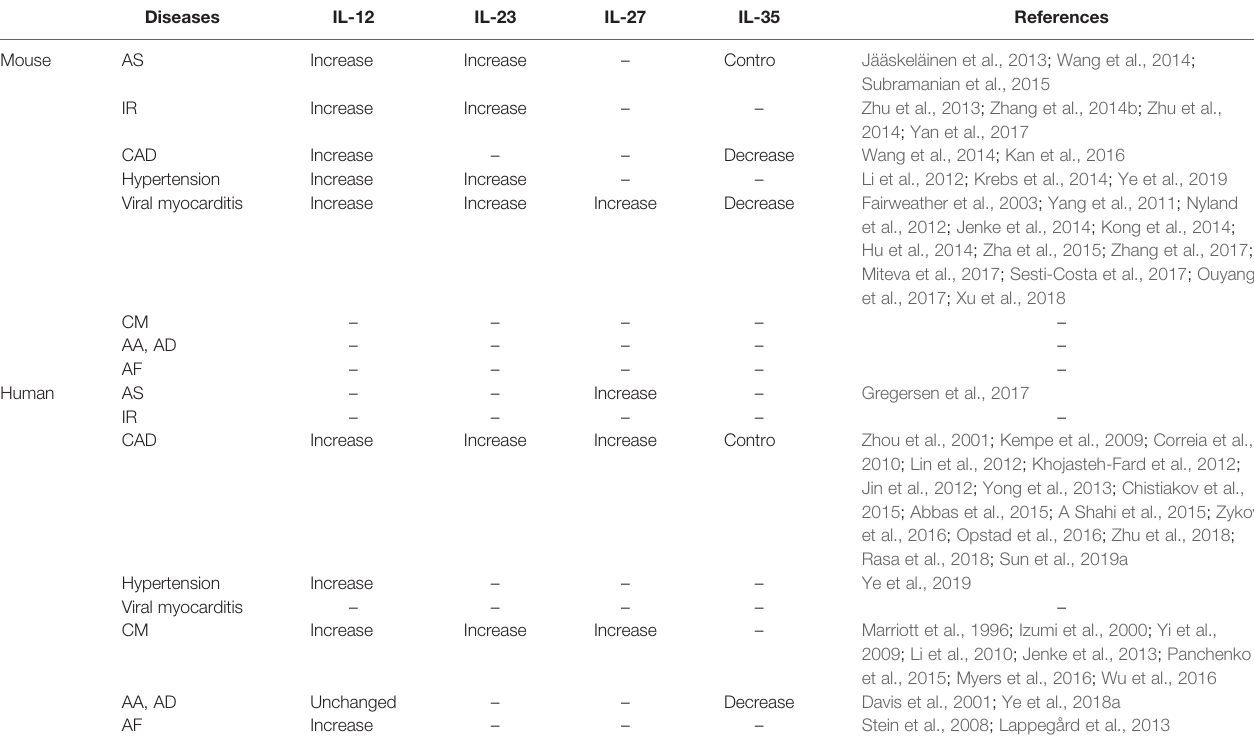
TABLE 2 | Expression of IL-12 family members in cardiovascular diseases.